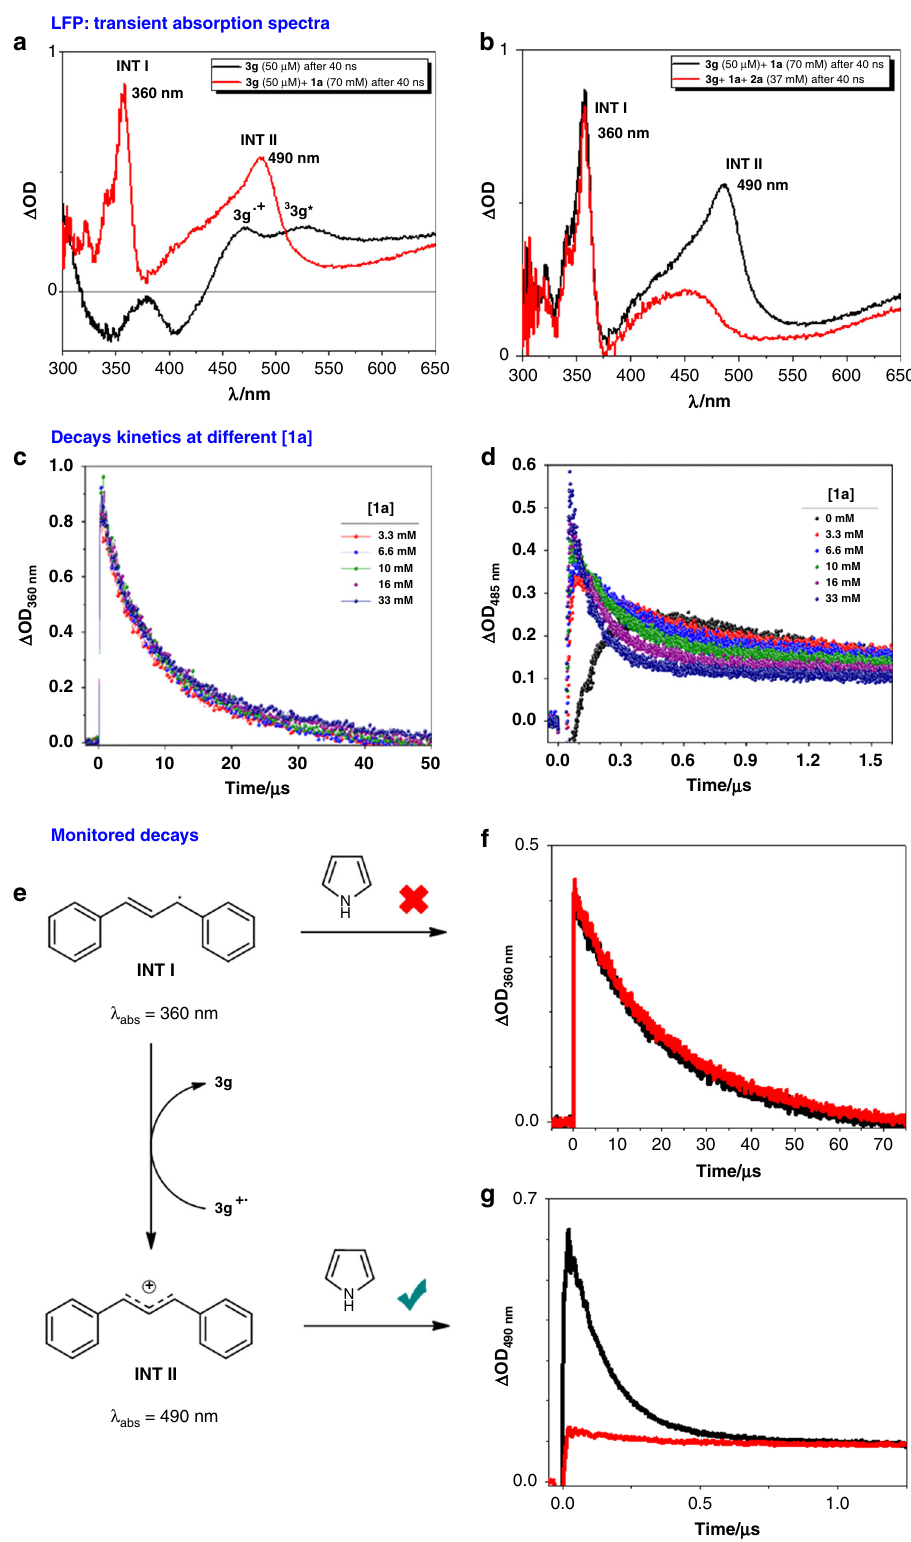
Fig. 4 Laser fl ash photolysis ( λ exc = 355 nm, MeCN/Ar) experiments. a Transient absorption spectra recorded at 40 ns after the laser pulse of 3g (50 mM) without 1a (black), with 70 mM of 1a (red). b Transient absorption spectra recorded at 40 ns after the laser pulse of 3g (50 mM) with 70 mM of 1a (black) and with 35 mM of 2a (red). c Decay kinetics at 360 nm after 355-nm LFP of 3g (50 µ M) in the presence of increasing amounts of 1a . d Decay kinetics at 485 nm after 355-nm LFP of 3g (50 µ M) in the presence of increasing amounts of 1a . e Scheme of the formation of intermediate II from intermediate I and their reaction with 2a . f Lifetime of INT I : decays monitored at 360 nm of 3g (50 mM) and 1a (70 mM) (black line) and in the presence of 2a (37 mM) (red line). g Lifetime of INT II : decays monitored at 490 nm of 3g (50 mM) and 1a (70 mM) (black line) and in the presence of 2a (37 mM) (red